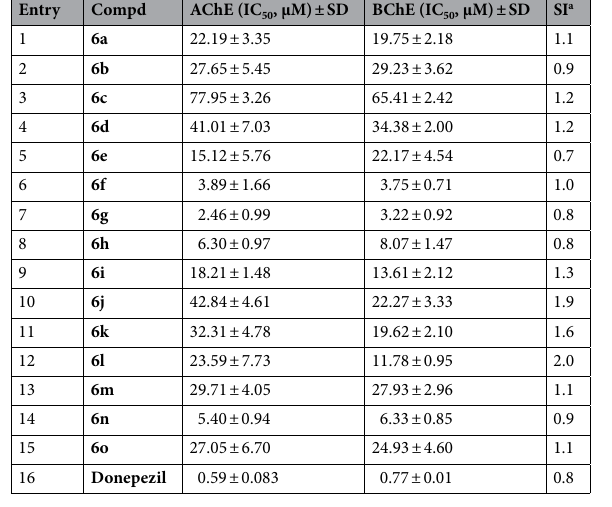
Table 6. AChE and BChE inhibition properties of the synthesized spiro-3-indolin-2-ones 6a ‒ o and standard reference (donepezil). a SI = IC 50 (AChE)/IC 50